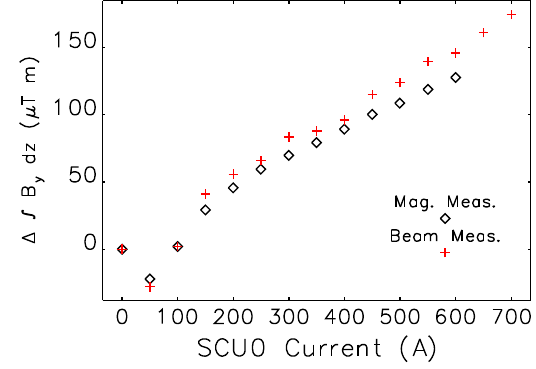
FIG. 18. Field integral measurement with beam.